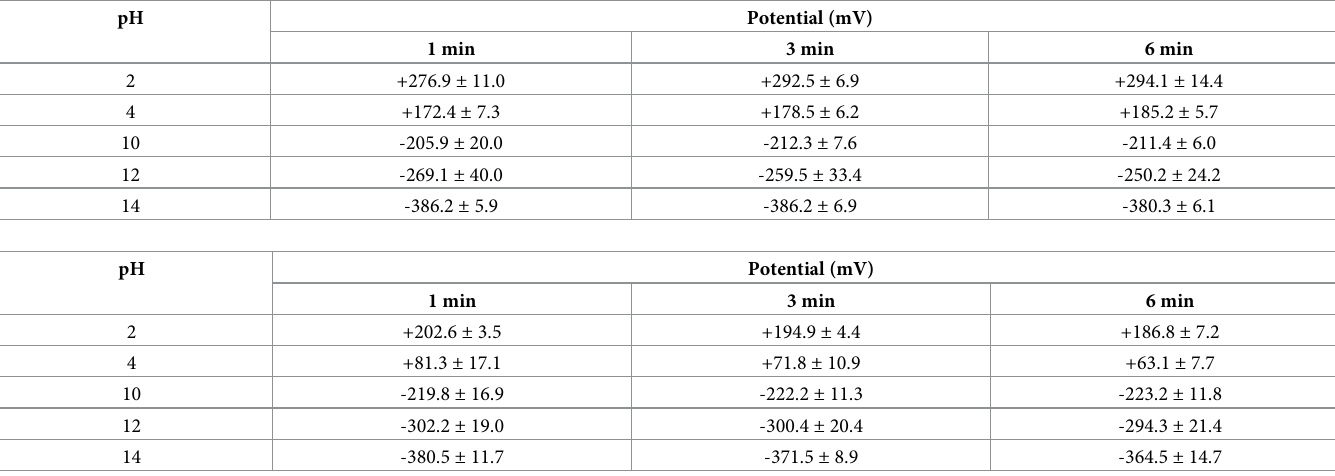
Table 1. (a) Electrical potential differences between acids (HCl) with differing pH values and neutral solutions (containing 1 μ M NaCl); and, bases (NaOH) and neu- tral solutions (containing 1 μ M NaCl). Measurements taken at different times to test stability a . (b) Electrical potential differences between acids (HNO 3 ) and neutral solu- tions (containing 1 μ M NaCl); and, bases (KOH) and neutral solutions (containing 1 μ M NaCl) a